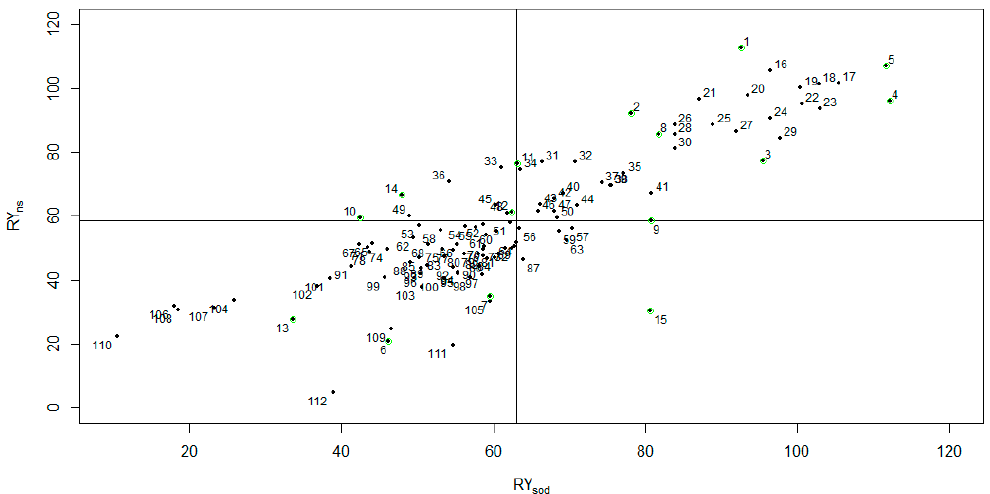
Figure 1. Relative grain yields of 112 wheat lines in sodic and non-sodic soil in 2018. The green circles represent selected lines used for detailed studies presented here.